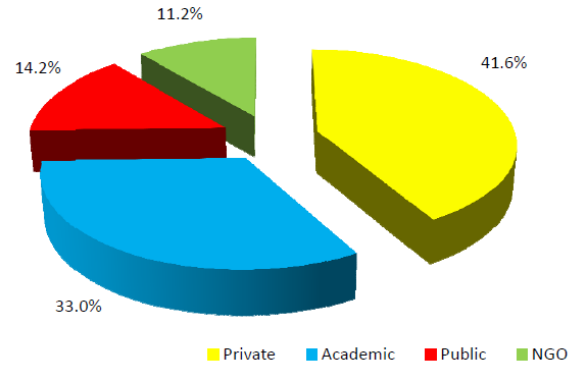
Fig. 3: The organisations’ sector in which the respondent worked (n=197). Source: EC, 2011, p.